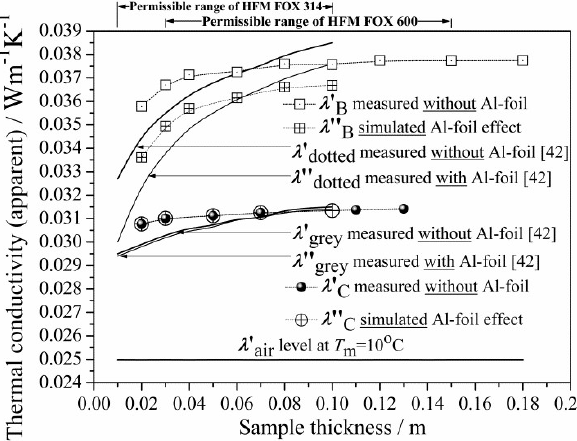
Figure 8. The effects of Al-foil and GMP on the thermal conductivity of EPS. The dotted squares and black spheres show the apparent thermal conductivity λ ’( d ) at T m = 10 °C for EPS B and C, respectively. The crossed squares and circles show the simulated data of λ ’’( d ) for EPS B and C with Al-foil. The solid lines are plotted based on data from [42]. The thin and thick lines indicate tests with and without Al-foil, respectively.